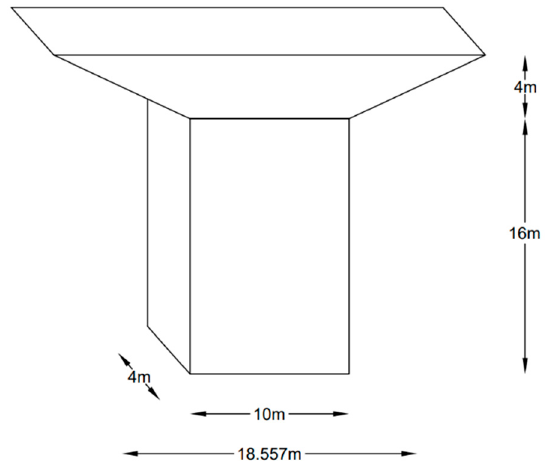
Figure 1. Pier dimensions in